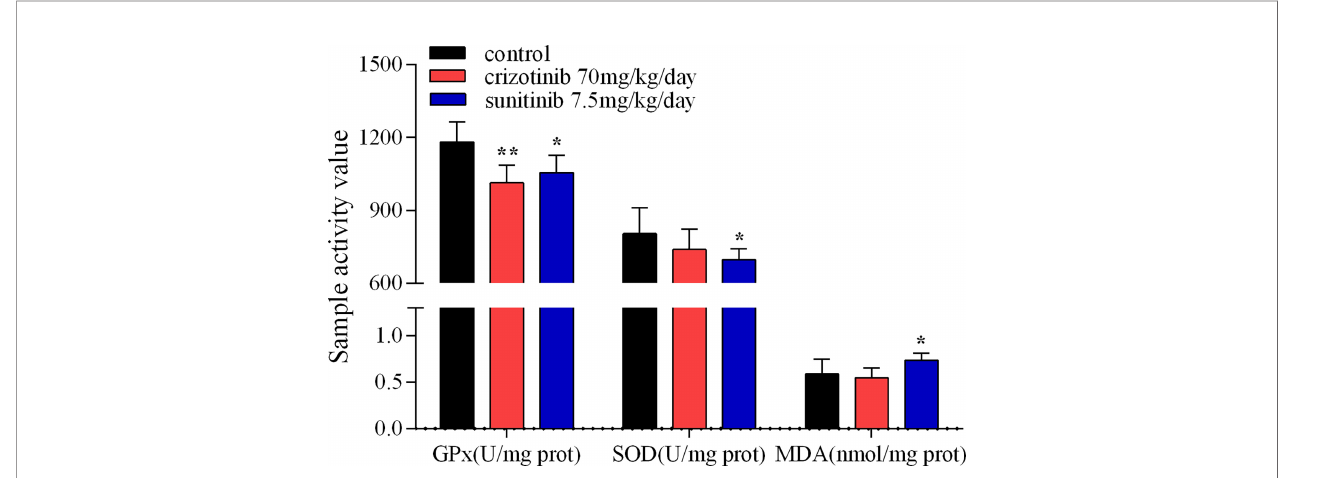
FIGURE 6 | The activity assay of hepatic GPx, SOD and MDA in mice treated with crizotinib or sunitinib (n = 6-8). *P < 0.05 and **P < 0.01 (the crizotinib or sunitinib alone vs. control). GPx, glutathione peroxidase; SOD, superoxide dismutase; MDA,